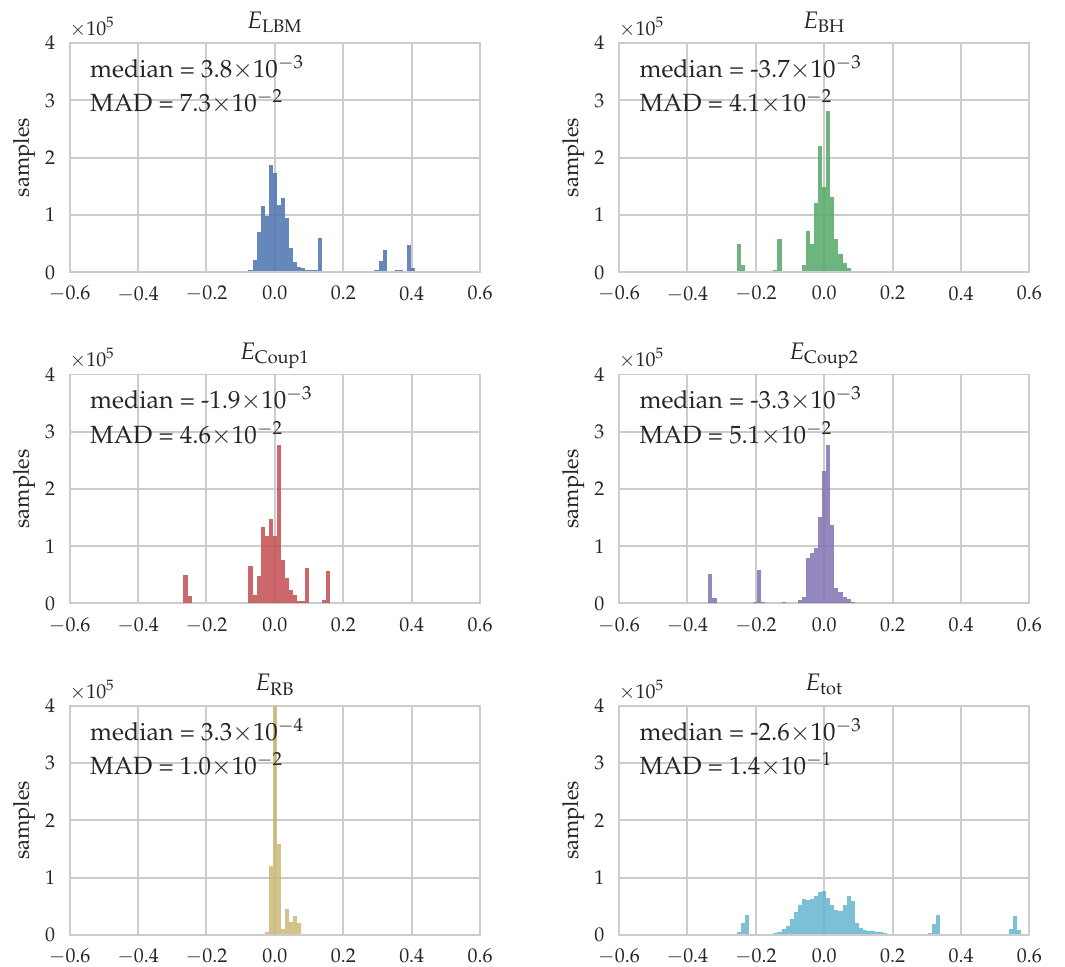
Figure 8. Relative errors E X of predicted workload for the five different parts and the total